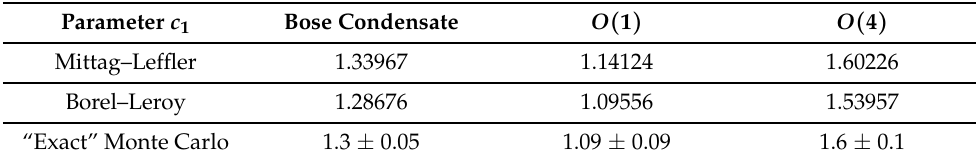
Table 1. Different types of transforms and summations applied to calculation of the parameter c 1 , defining shift of the Bose–Einstein condensation temperature and to analogous models. Parameter c 1 quantifies a shift of the transition temperature compared with the ideal